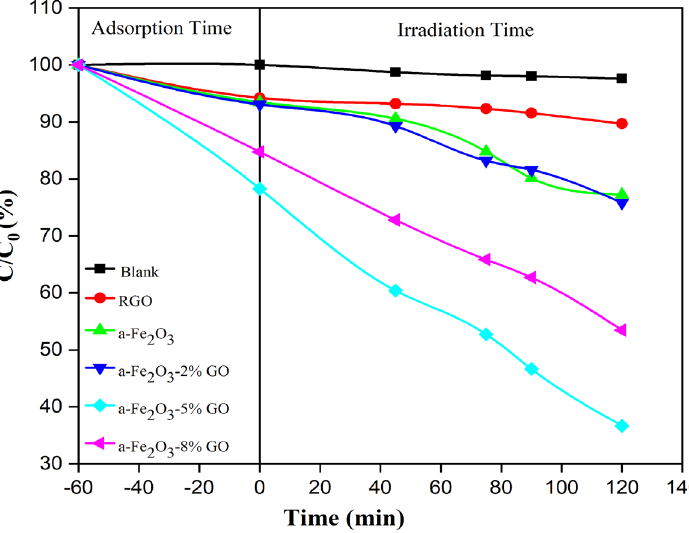
Figure 11. The photocatalytic result of all powder nanocomposites with pure Fe 2 O 3 .